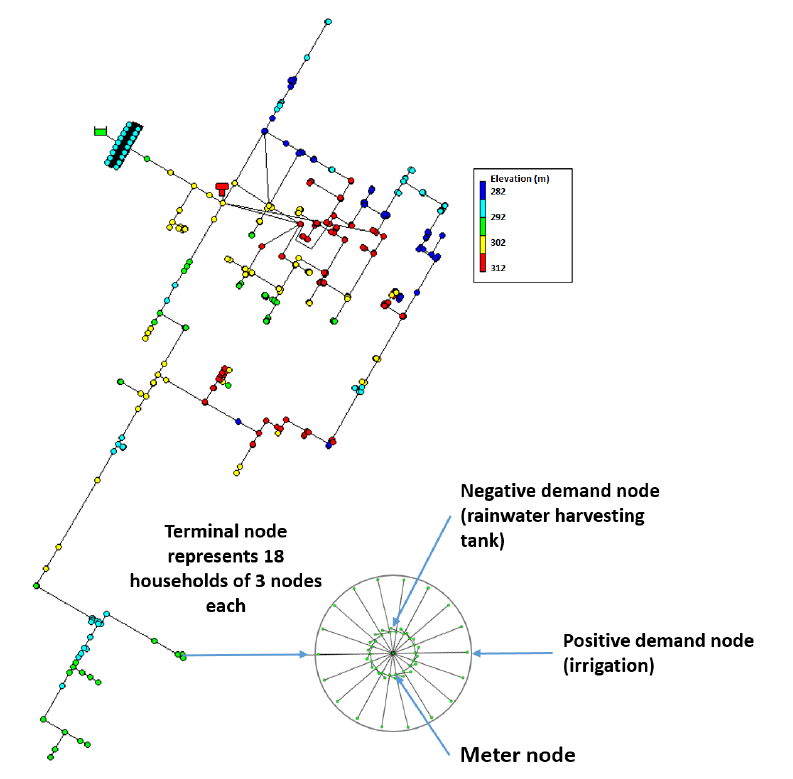
Figure 4. Wolfpack City water model. Each terminal node represents 18 households, which are represented using three nodes each: a meter node, positive demand node, and negative demand